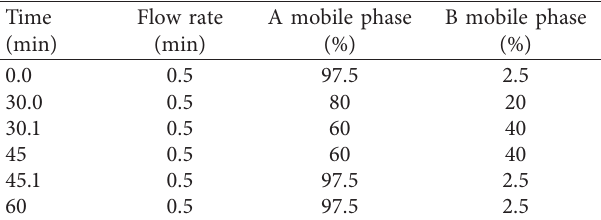
Table 1: The eluted conditions of the monosaccharide